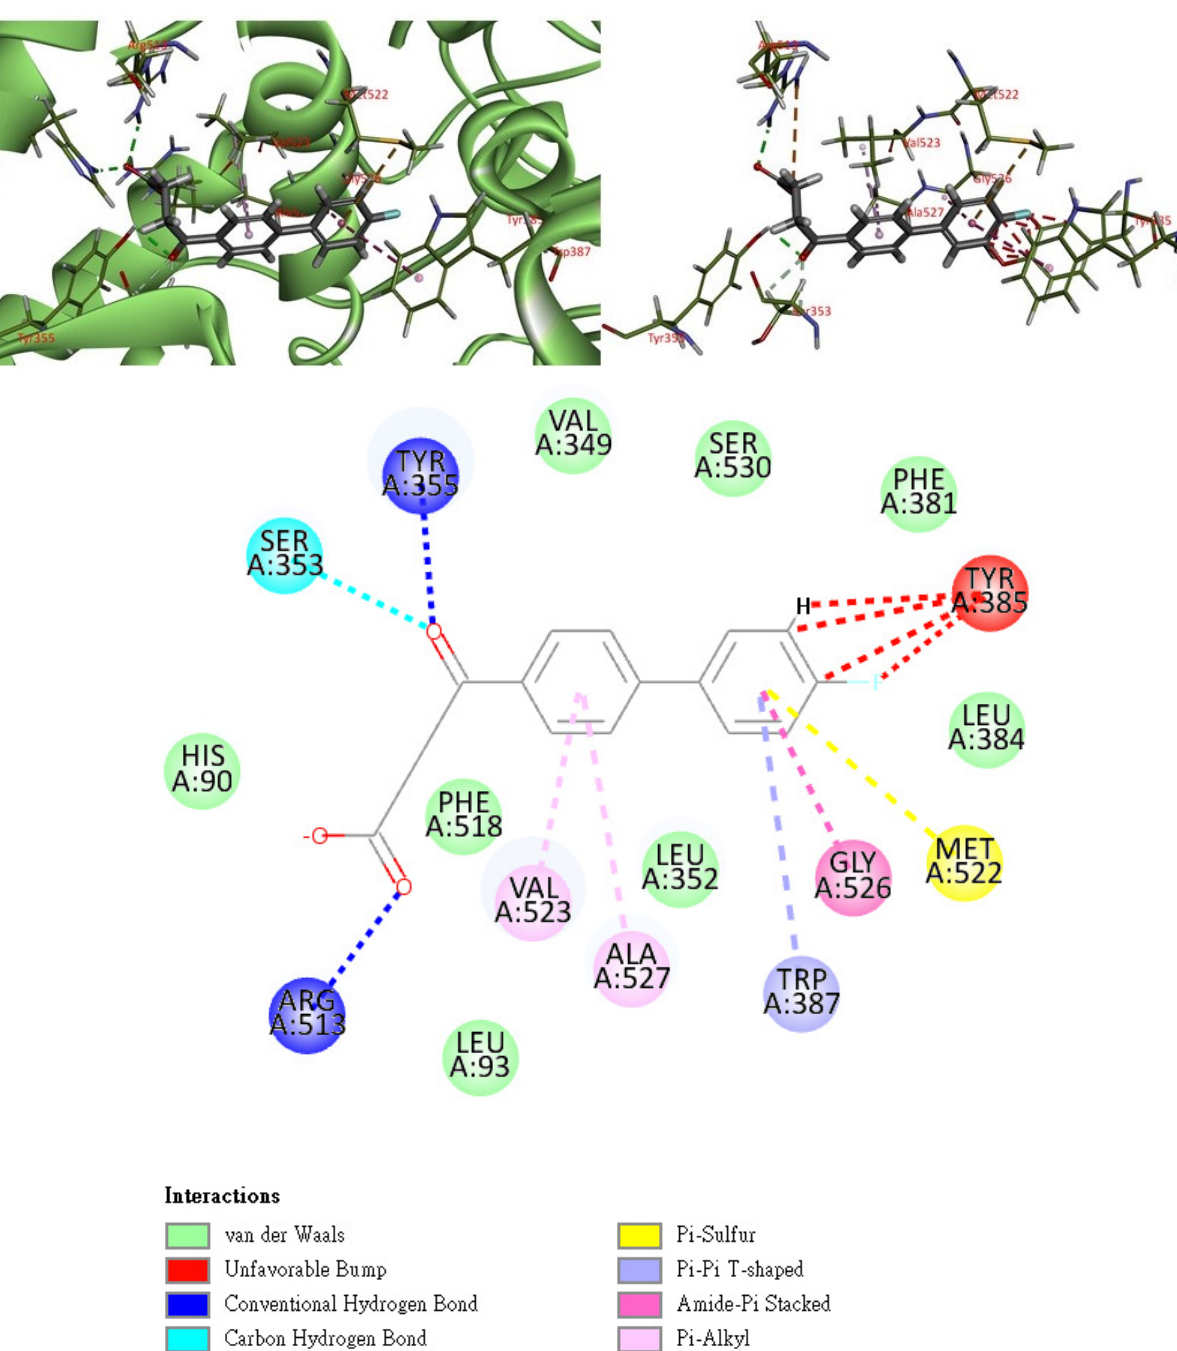
Figure 9. The 3-dimensional and 2-dimensional representations of the interaction of fluoro compound 6a with the active site of COX-2 enzyme (1CX2). The subunits responsible for interacting with compound 6a are labeled in color and the interactions are denoted by the dotted lines.